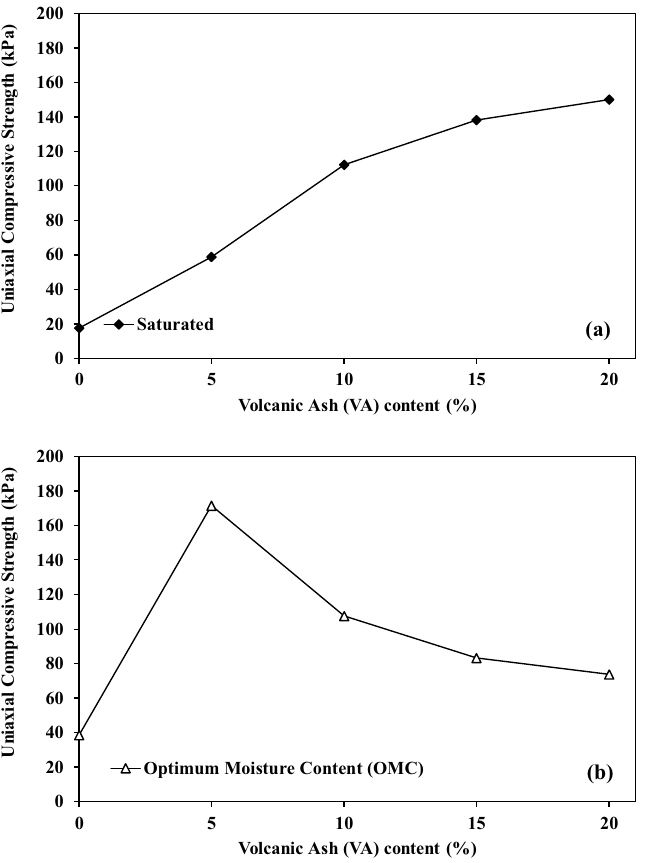
Figure 9. Influence of volcanic ash (VA) content on uniaxial compression strength (UCS); ( a ) at saturated condition, ( b ) at optimum moisture content (OMC) condition.